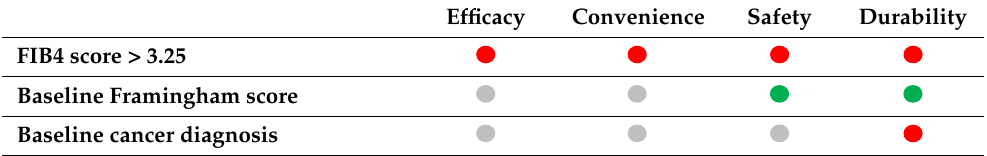
Table 4. Summary of the risk and protective factors associated with the study metrics.